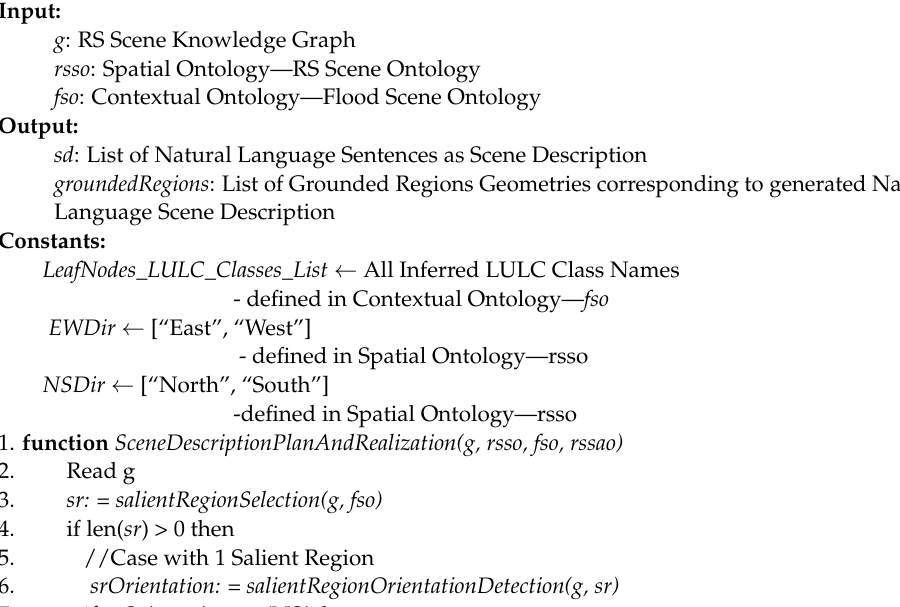
Algorithm 3 Grounded Scene Description Planning and